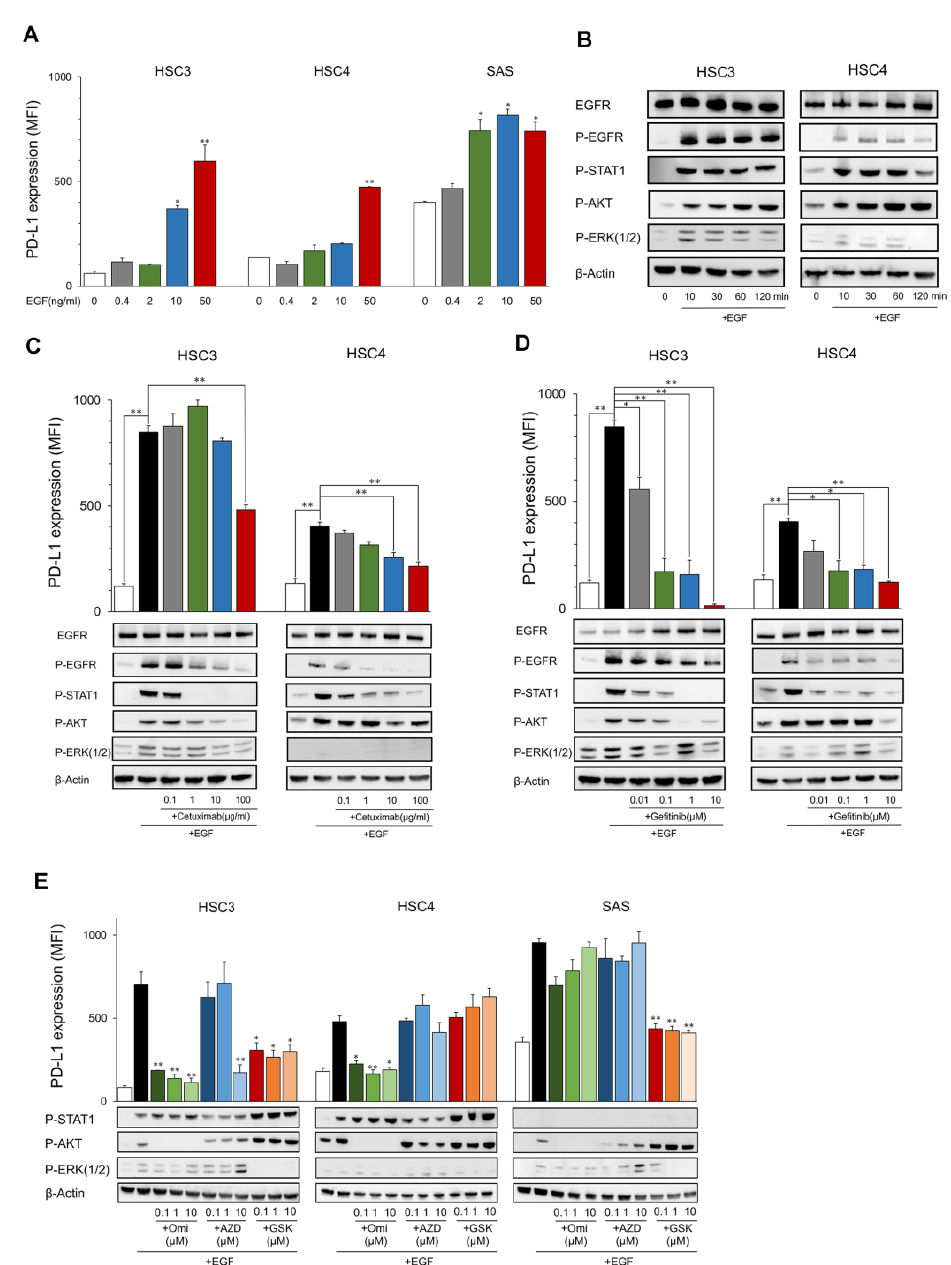
Figure 1. Expression of PD-L1 and phosphorylation of EGFR downstream proteins by EGF. ( A ) OSCC cell lines were treated with EGF at the indicated dose. PD-L1 expression was tested by flow cytometry. Statistical analysis was performed on the results of EGF 0 ng/mL. ( B ) Cells were treated with EGF (50 ng/mL) each time, and the phosphorylation of EGFR downstream proteins was evaluated by Western blotting. ( C , D ) Cetuximab and gefitinib were added into the OSCC cell culture at the indicated dose 60 min before EGF treatment (50 ng/mL). PD-L1 expression and the phosphorylation of EGFR downstream proteins were evaluated after 24 h and 60 min, respectively. ( E ) Omipalisib, AZD1480, and GSK1120212 were added into the OSCC cell culture at the indicated dose 60 min before EGF treatment (50 ng/mL). PD-L1 expression and phosphorylation of EGFR downstream proteins were evaluated after 24 h and 60 min, respectively. Statistical analysis was performed for the addition of EGF alone. * p < 0.05, ** p < 0.01.